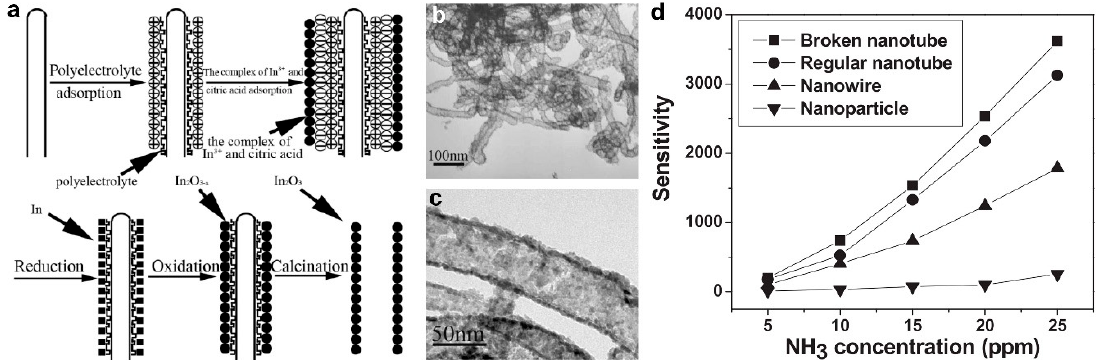
Figure 6. ( a ) Schematic diagram for the growth process of In 2 O 3 nanotubes. ( b , c ) TEM images of regular In 2 O 3 nanotubes prepared by the calcination of In 2 O 3 /polyelectrolyte/CNT nanocomposites at 550 °C in O 2 for 3 hours. ( d ) Sensitivity response versus ammonia concentration (5–25 ppm) at room temperature for four types of gas sensors based on In 2 O 3 nanostructures including broken In 2 O